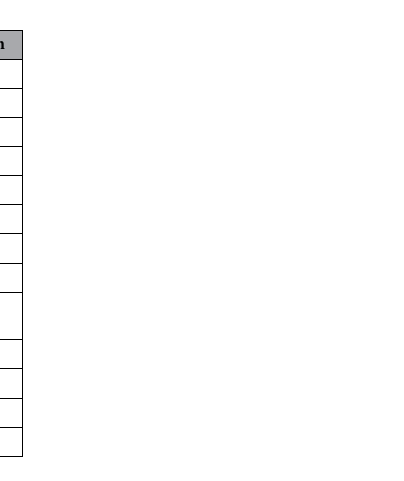
Table 1. Band parameters of the Sentinel-2A MSI